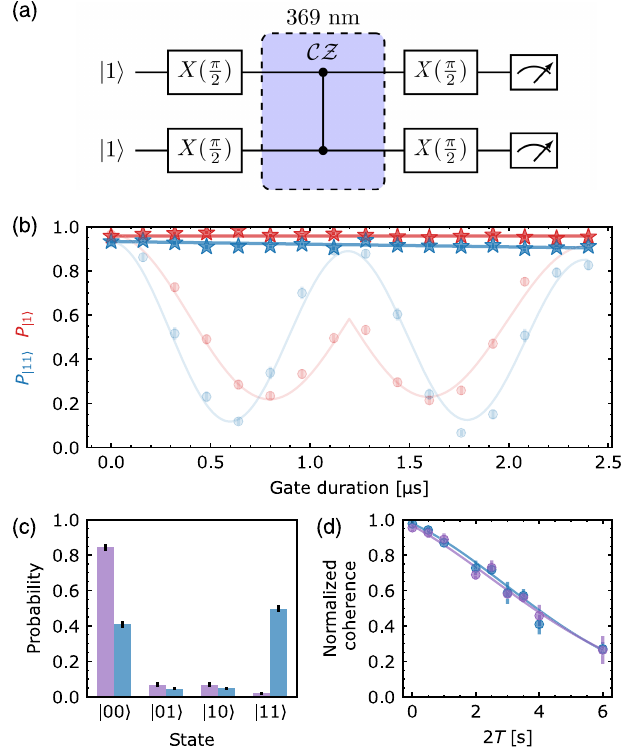
FIG. 5. Coherent control of a Rydberg gate using an ion core light shift. (a) The two-qubit gate is suppressed by applying light near resonance with a Yb þ ion core transition (369 nm) during the gate. (b) Evolution of the states j 1 i (red stars) and j 11 i (blue stars) during a suppressed gate. The dynamics without the control light are shown for comparison [reproduced from Fig. 4(c)]. (c) Measured state populations with (purple) and without (blue) the control light. (d) Coherence of the nuclear spin in 1 S 0 under continuous illumination with the control light (purple). The measured T 2 ¼ 5 . 1 ð 7 Þ s is consistent with Fig. 3(b) (reproduced here, in blue). In all panels, the error bars show (cid:3) 1 σ statistical